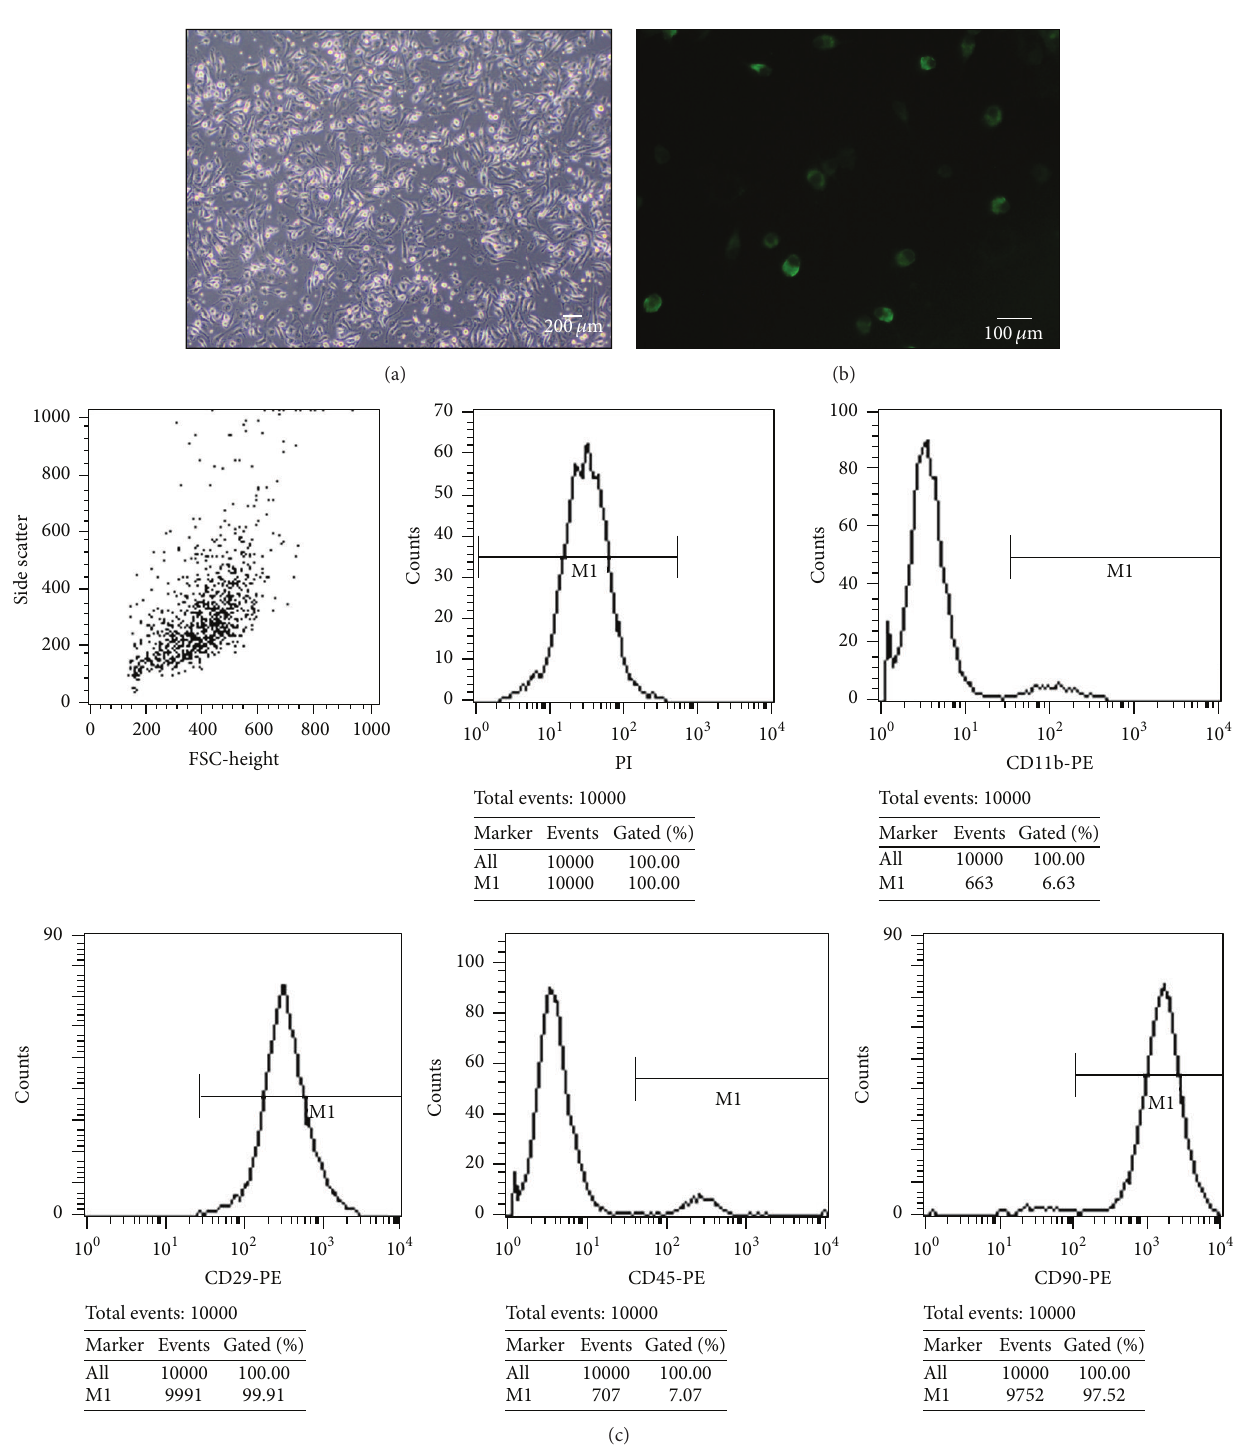
Figure 1: Evaluation of MSCs and BrdU-labeling efficacy. Primary cultured MSCs exhibit typical elongated, fibroblast-like morphology or large, flattened shape (a). Scale bar 200 𝜇 m . MSCs in third passage were positive for BrdU, as immunofluorescence stained with BrdU (b). Scale bar 100 𝜇 m . Flow cytometry analysis of the surface markers of bone marrow mononuclear cells: CD29 (99.91%), CD90 (97.52%), CD11b (6.63%), and CD45 (7.07%)